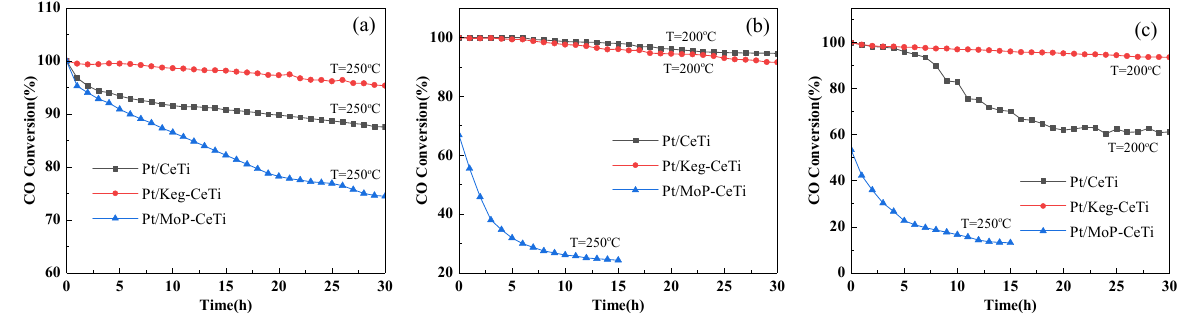
Figure 2. Durability of the Pt/CeTi, Pt/Keg-CeTi, and Pt/MoP-CeTi catalysts at constant tempera- tures in the presence of SO 2 ( a ), H 2 O ( b ), and both of them ( c ). Reaction conditions: [CO] = 1%, [O 2 ] = 6 vol%, [H 2 O] = 10% (when used), [SO 2 ] = 100 ppm (when used), balance He, total flow rate = 667 mL/min, GHSV = 4 × 10 5 h − 1 .